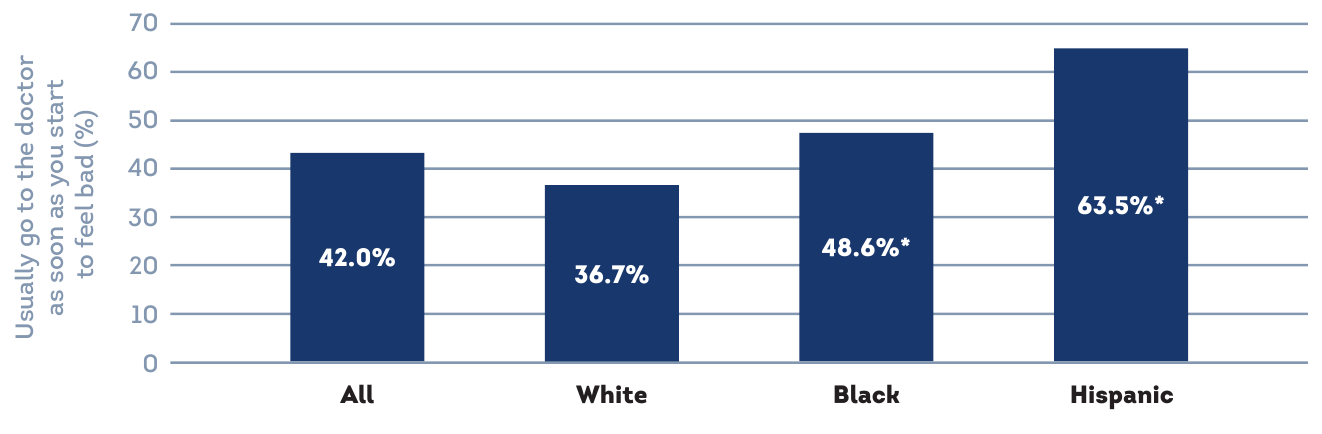
Figure 3. Percentage reporting they usually go to the doctor as soon as they start to feel bad, among community-dwelling Medicare beneficiaries with self-reported diagnosed diabetes,